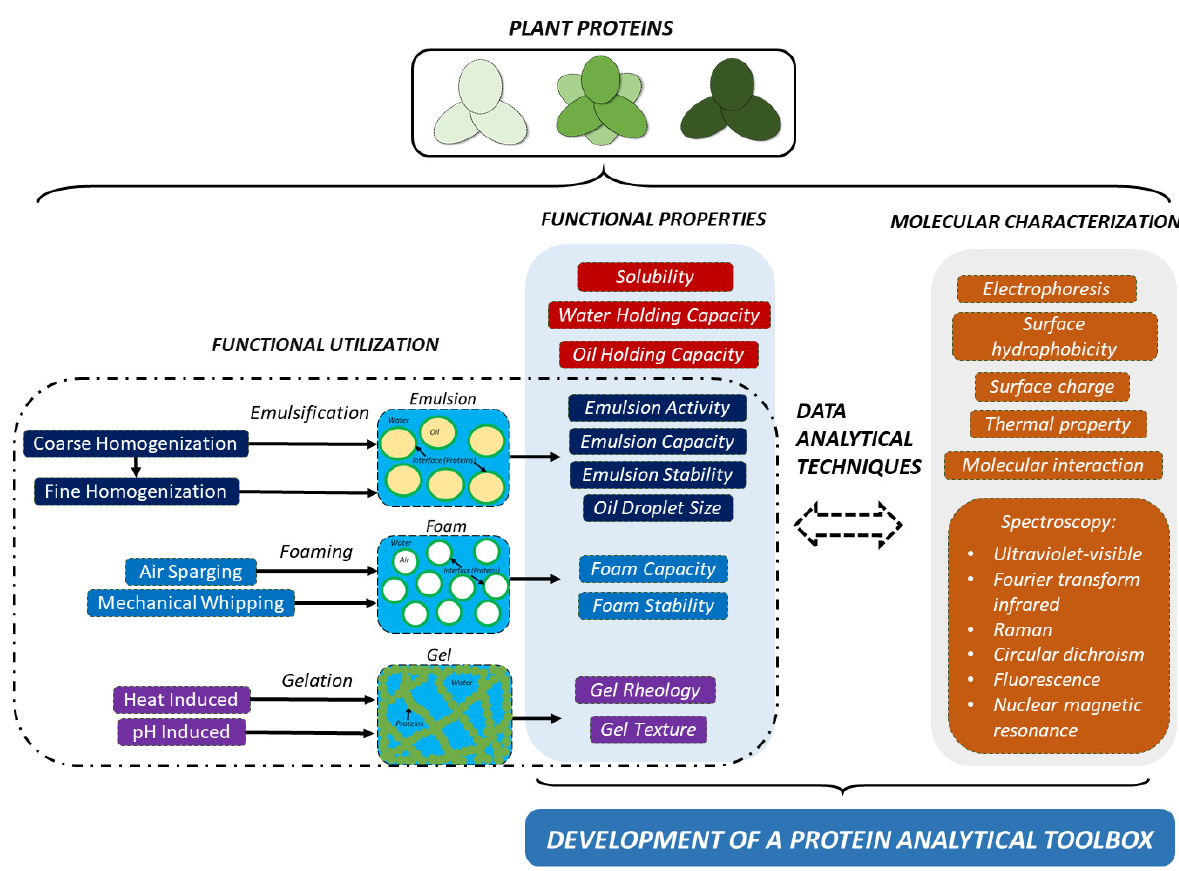
Figure 3. Illustration of functional utilization, functional properties, molecular characterization, and the protein analytical toolbox used to characterize proteins.